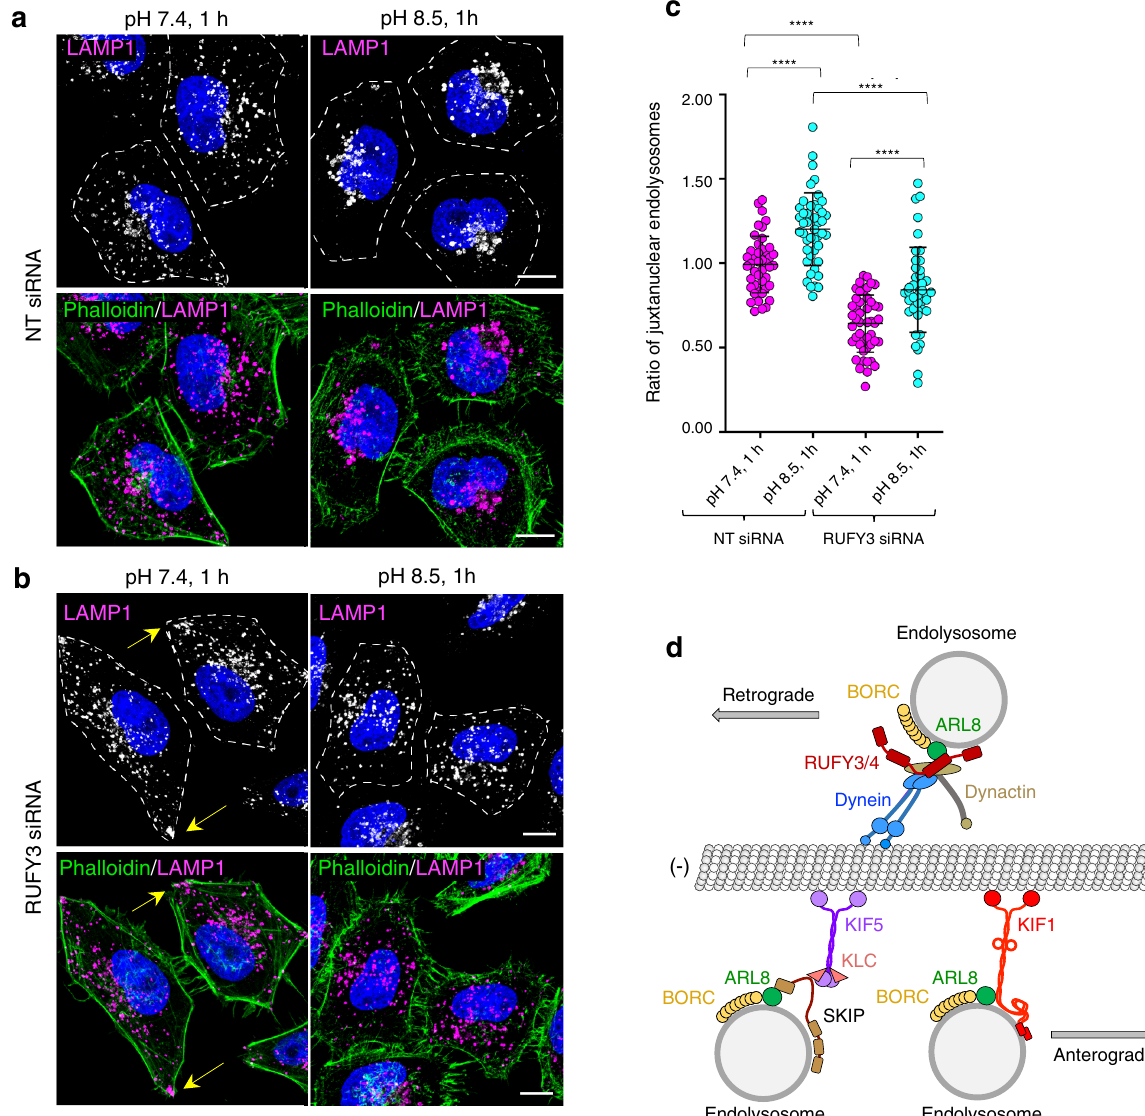
Fig. 9 Requirement of RUFY3 for juxtanuclear clustering of endolysosomes upon cytoplasmic alkalinization, and schematic representation of the roles of ARL8 in retrograde and anterograde endolysosome transport. a , b HeLa cells were treated with non-targeting ( a ) or RUFY3 siRNA ( b ) for 96 h, and left untreated (control) or incubated for 1 h at 37 °C in regular culture medium adjusted to pH 8.5. Cells were then fi xed, permeabilized and immunostained with antibody to endogenous LAMP1 (grayscale and magenta) and Alexa Fluor 546-conjugated phalloidin (green). Nuclei were stained with DAPI (blue). Arrows point to accumulation of endolysosomes at cell tips caused by RUFY3 depletion. Scale bars: 10 μ m. c Quanti fi cation of the ratio of juxtanuclear LAMP1 to total LAMP1 by shell analysis. The graph shows the individual data points and the mean ± SD from one experiment (panels ( a ) and ( b )). Data were normalized to untreated cells in regular culture medium. Statistical signi fi cance was calculated by two-way ANOVA with multiple comparison between groups using Tukey ’ s test. **** p < 0.0001. d Schematic representation of the role of ARL8 in regulating both retrograde and anterograde of endolysosomes through interactions with different effectors. BORC promotes recruitment of ARL8 to endolysosomes 7 . In turn, ARL8 recruits RUFY3 or RUFY4, which promotes coupling to dynein-dynactin. Interaction of ARL8 with RUFY3 is mediated by the CC2 domain. The domain of RUFY4 that interacts with ARL8 was not identi fi ed. These interactions drive transport of endolysosomes from the plus to the minus end of microtubules (i.e., retrograde transport) (this study). Additional RUFY3 or RUFY4 interactors not represented here may also participate in this coupling 91 . Alternatively, ARL8 recruits kinesin-1 (KIF5 2 -KLC 2 ) via SKIP, or kinesin-3 (KIF1) directly, driving endolysosome transport from the minus to the plus end of microtubules (i.e., anterograde transport) 7,11,17,20